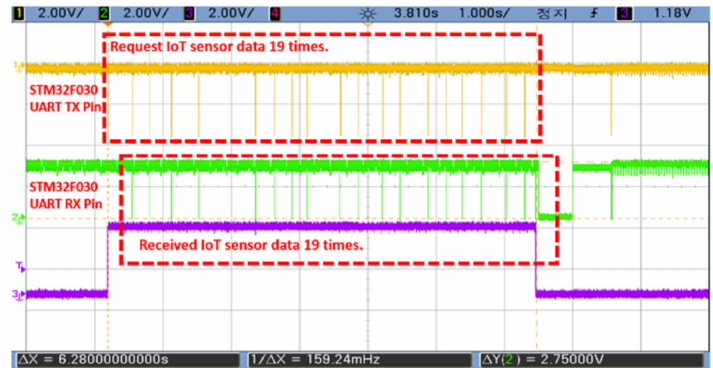
Figure 13. Data sent and received after the scan connection interval